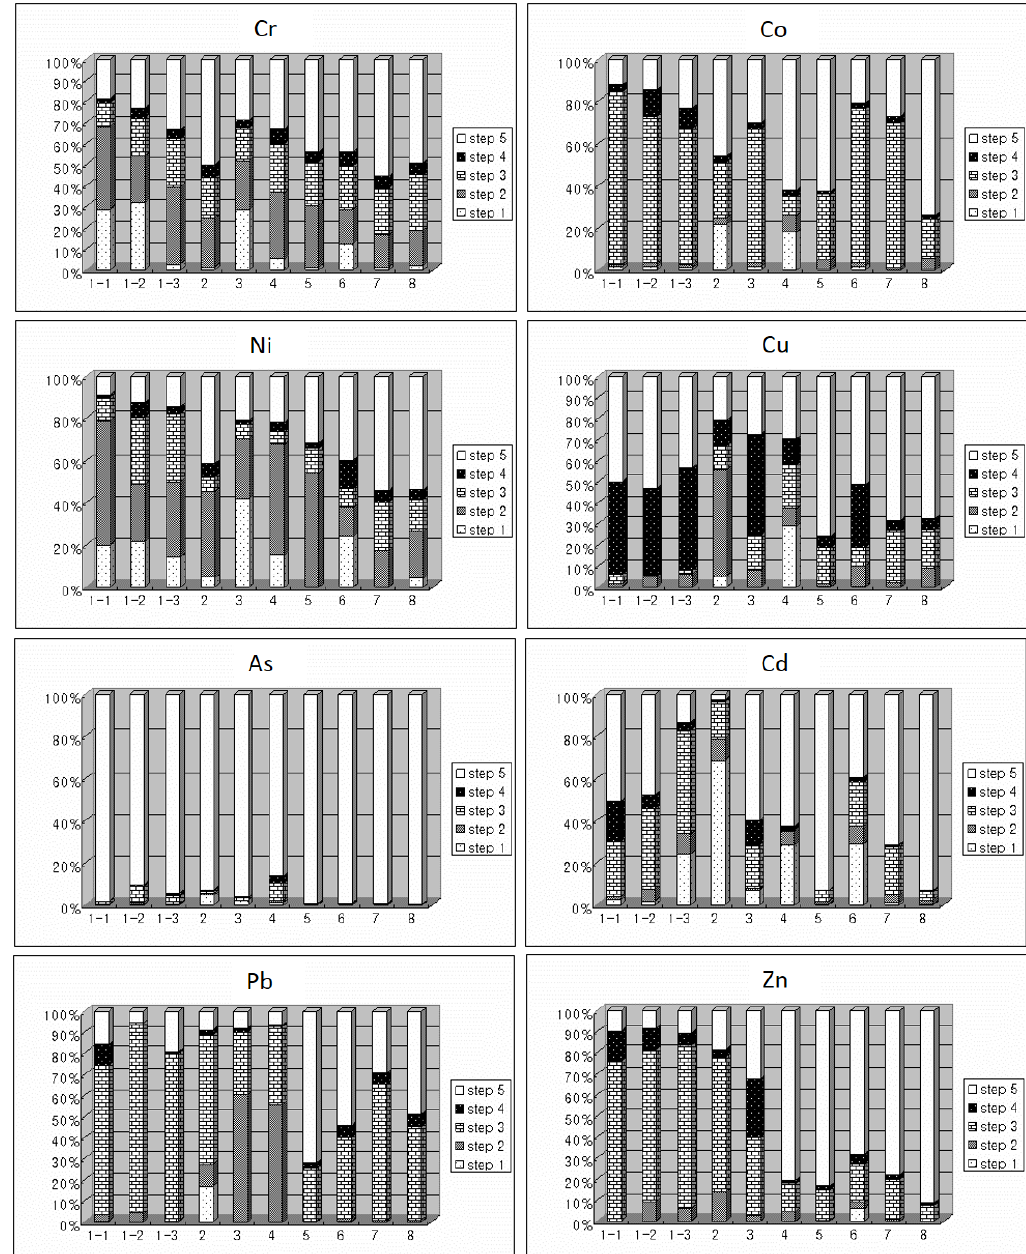
Figure 4. Relative abundance of the sequentially extracted potentially toxic elements for